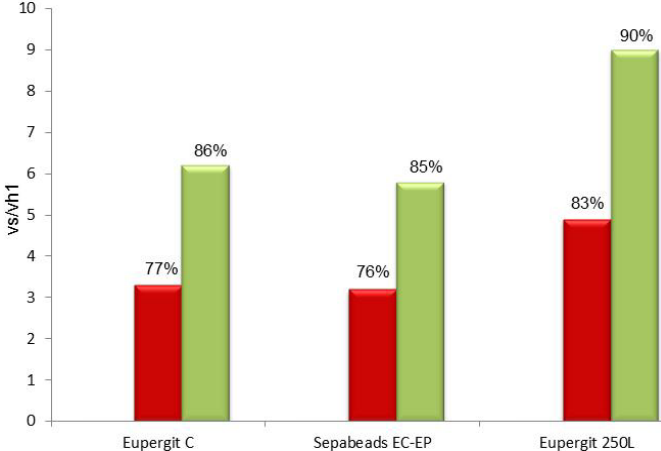
Figure 6. Vs/vh and percentage of conversion (synthesis of mandelyl-7-ACA) of PGA 1 immobilized on epoxy acrylic carriers (Eupergit ® C, Sepabeads ® EC-EP and Eupergit ® 250L) before and after quenching with